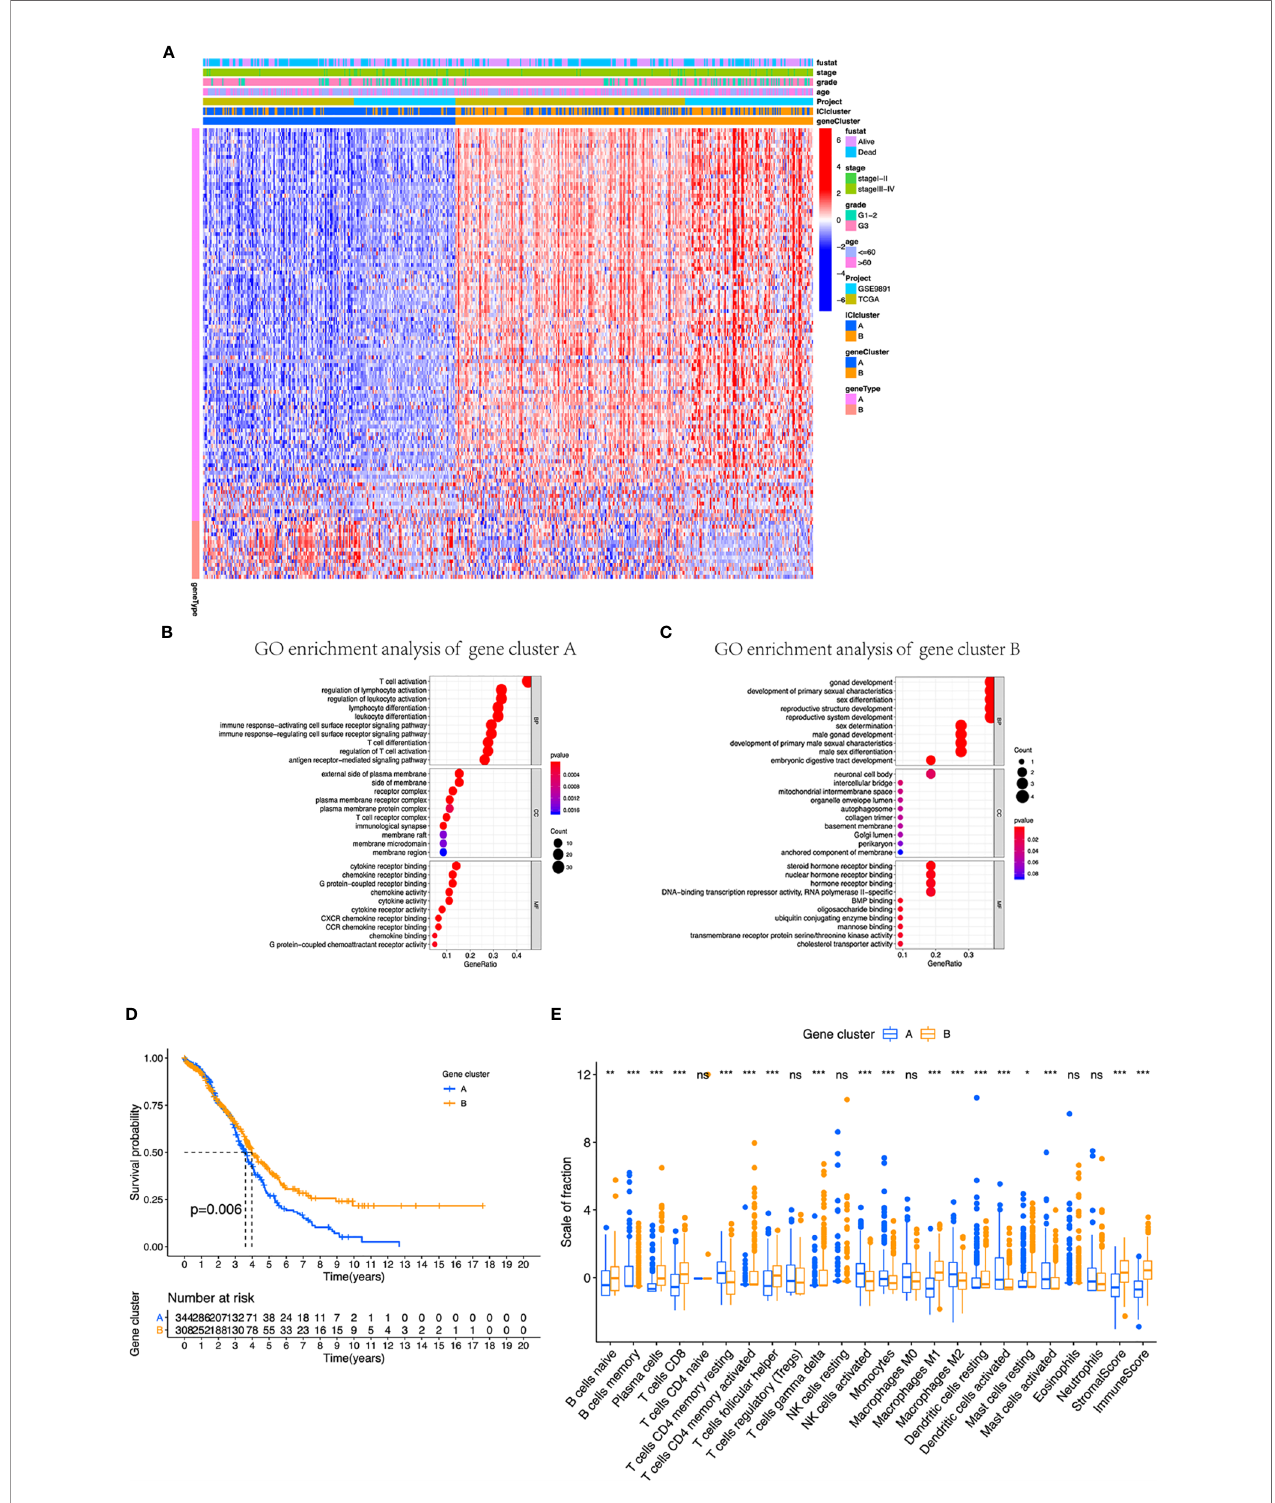
FIGURE 3 | Identi fi cation of immunogenic gene subtypes in the TME of OC. (A) Unsupervised clustering of common DEGs derived from two ICI cluster groups helped divide patients into two subgroups: gene clusters A and B. (B, C) Gene Ontology (GO) enrichment analysis of the gene clusters A and B. (D) OS of all patients was compared between two gene clusters applying Kaplan – Meier curves. (E) Cellular fraction of the tumor-in fi ltrating immune cell types in gene clusters A and B, including stromal score and immune score. * p < 0.05; ** p < 0.01; *** p < 0.001; ns, not signi fi